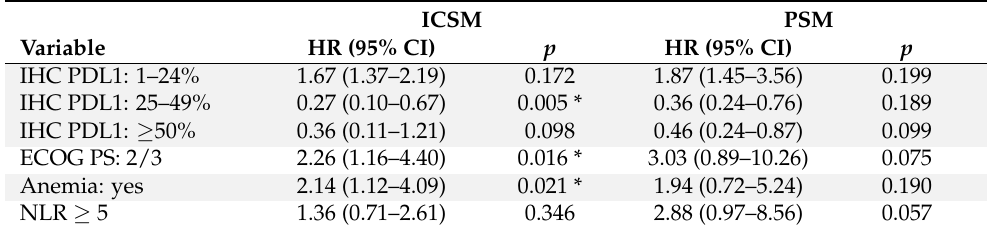
Table 4. Results from multivariate Cox proportional hazard regression model for time to